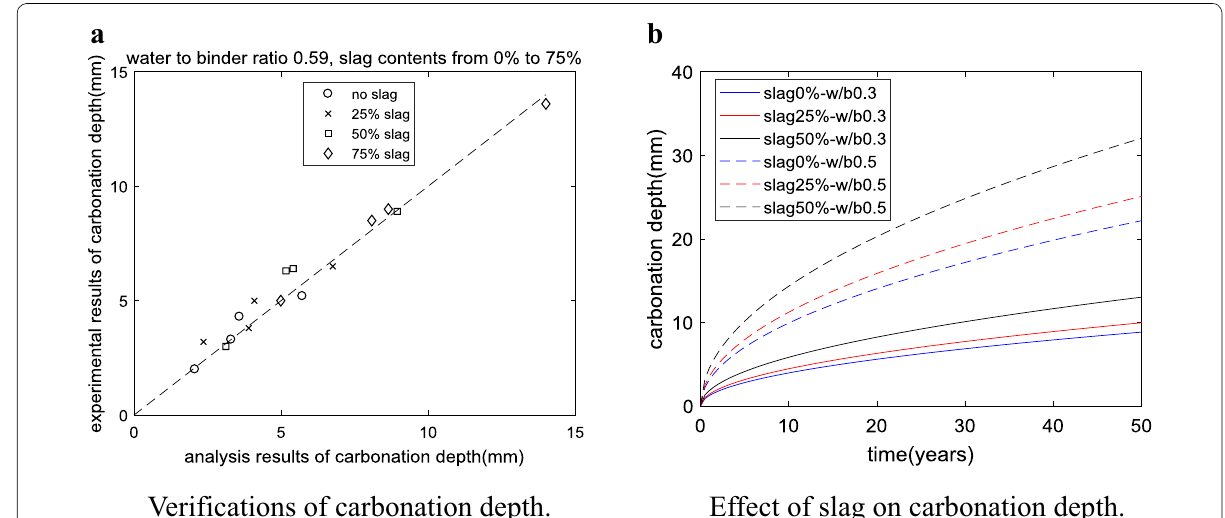
Fig. 2 Verifications and parameter analysis of carbonation